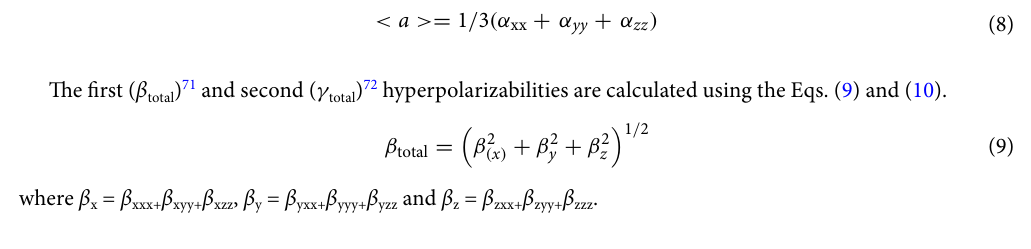
Figure 5. A pictorial display of DOS for TPBR1 and TPBD2-TPBD6 . Figures are drawn by utilizing PyMOlyze 1.1 version (https:// sourc eforge. net/ proje cts/ pymol yze/). All out put flies of entitled compounds were computed through Gaussian 09 version D.01 (https:// gauss ian. com/ g09ci